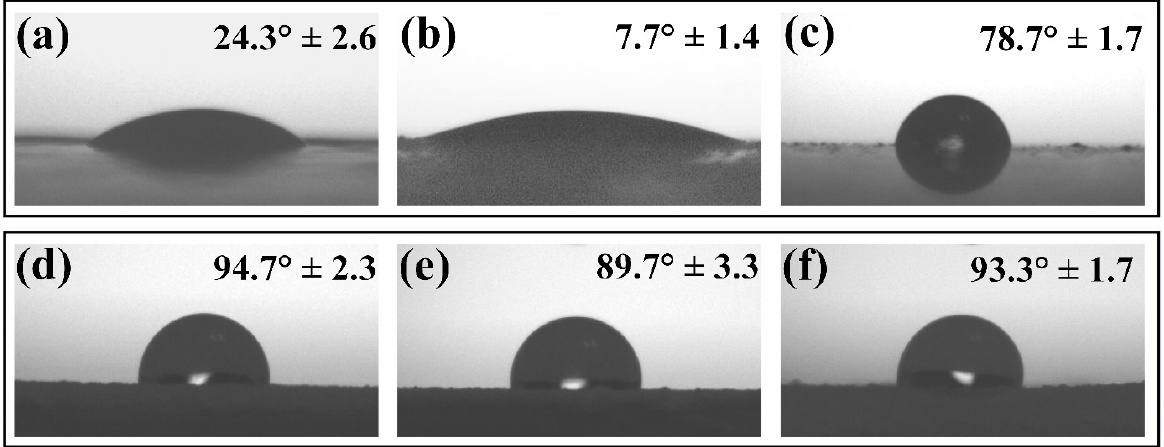
Figure 7. Water droplet contact angle on ZnO coatings on polycarbonate substrate: ( a ) binder-A non-loaded ZnO particles; ( b ) ZnO-aloe loaded in binder-A; ( c ) ZnO-starch loaded in binder-A; ( d ) paint-W non-loaded ZnO particles; ( e ) ZnO-aloe loaded in paint-W; and ( f ) ZnO-starch loaded in paint-W.